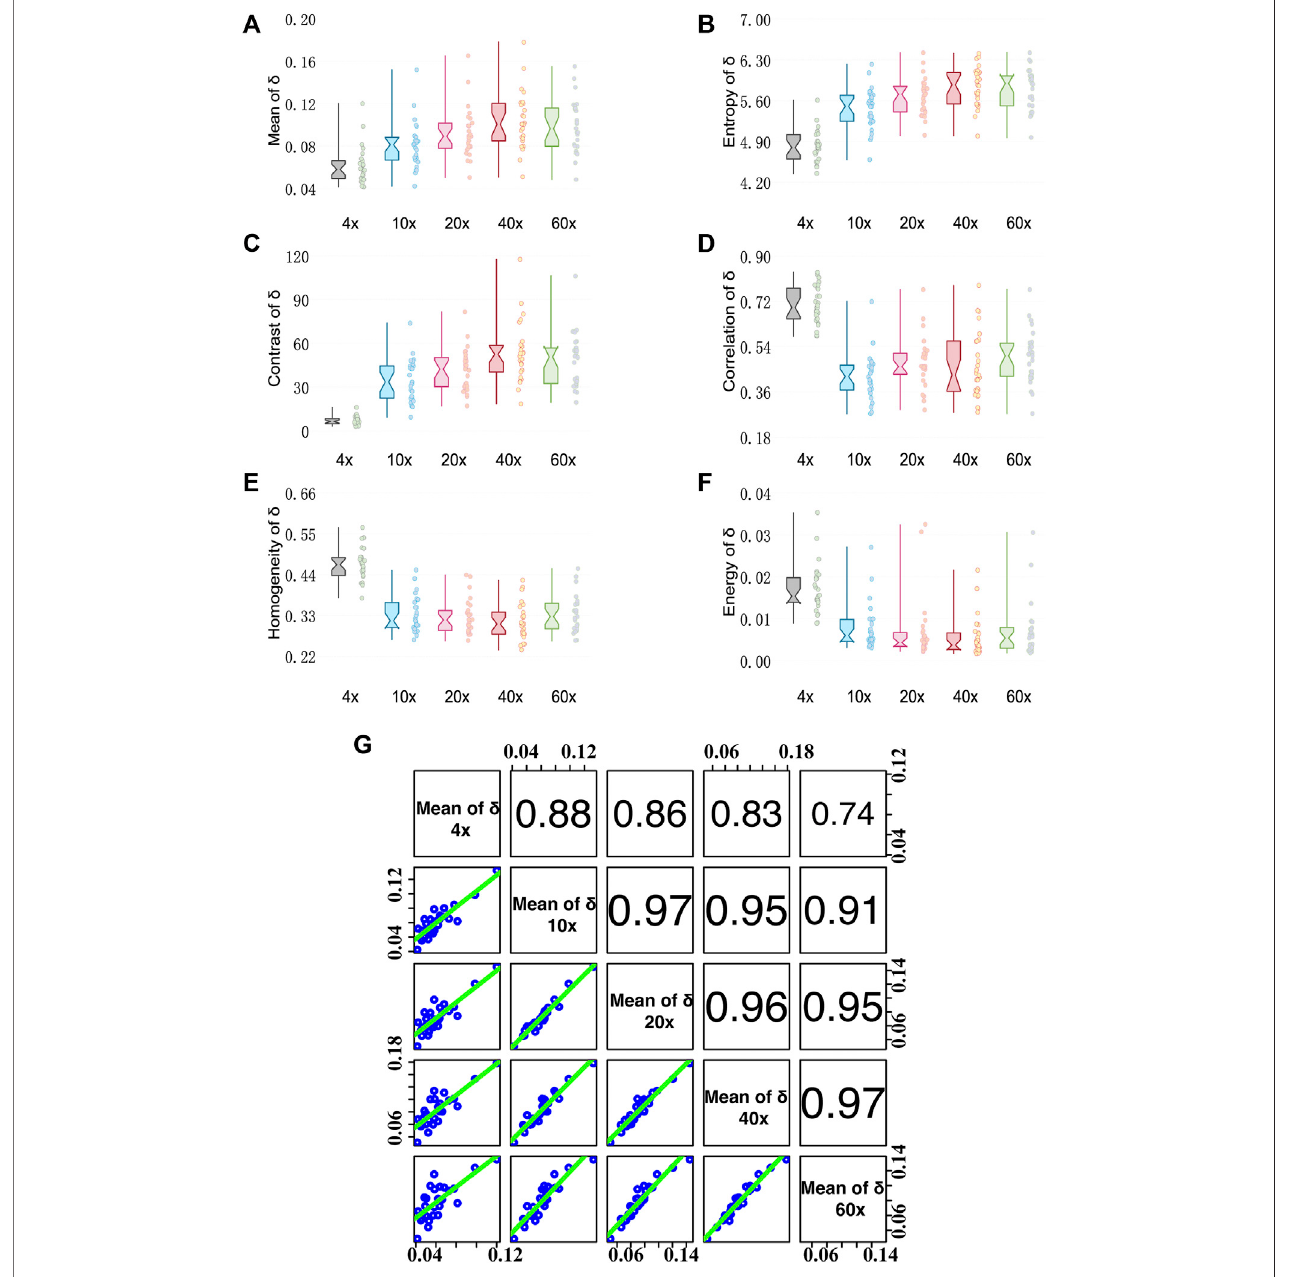
FIGURE 4 | Quantitative analysis results of MMPD parameter δ images under different magni fi cation objectives (4×/NA 0.10, 10×/NA 0.25, 20×/NA 0.40, 40×/NA 0.65, and 60×/NA 0.80). (A – F) Box plots of Mean, Entropy, Contrast, Correlation, Homogeneity, and Energy. (G) The Correlation coef fi cient R between two pairs of mean of δ at different magni fi cations. (cf. Figure 3I